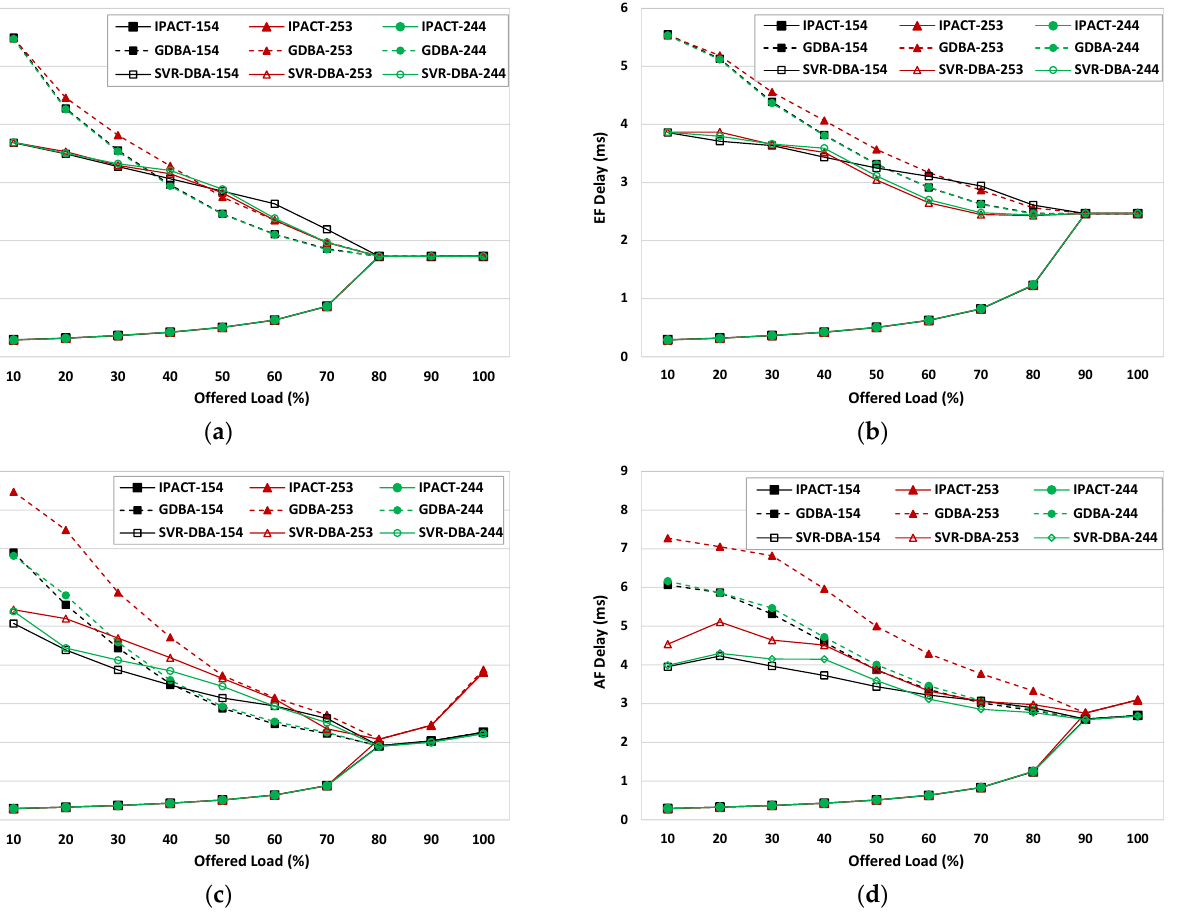
Figure 5. Packet delay for different scenarios. ( a ) EF packet delay for 1.0 ms cycle time; ( b ) EF packet delay for 1.5 ms cycle time; ( c ) AF packet delay for 1.0 ms cycle time; ( d ) AF packet delay for 1.5 ms cycle time.